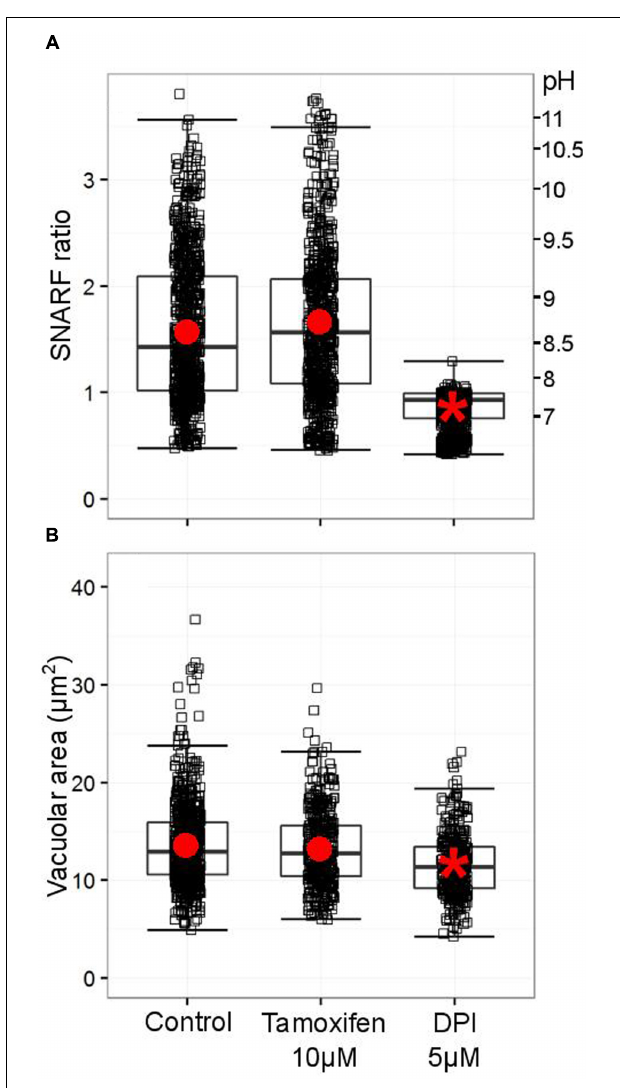
FIGURE 10 | (A) Distribution of SNARF fluorescence ratios measured on fully phagocytosed SNARF labeled Candida by WT and ebo/ebo neutrophils (733 and 735 Candida measured, respectively, compiled from three independent experiments). (B) Distribution of areas of vacuoles incorporating a single Candida in WT and ebo/ebo neutrophils (320 and 354 vacuoles measured, respectively, compiled from three independent experiments). Boxes show medians and interquartile ranges, compiled from three independent experiments. Red circles locate the mean